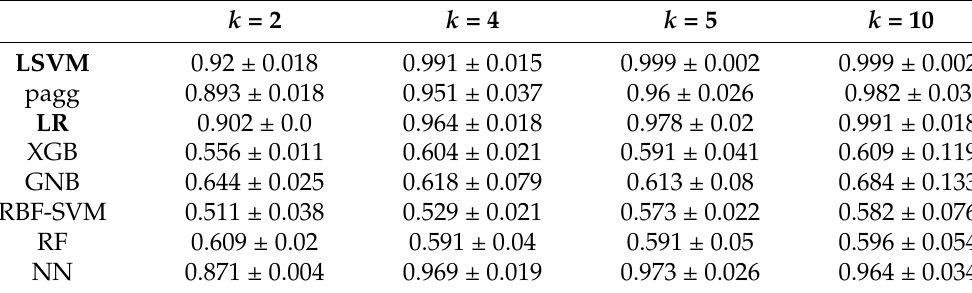
Table 3. Mean accuracy ± standard deviation across the k-folds, with k = 2, 4, 5, 10.